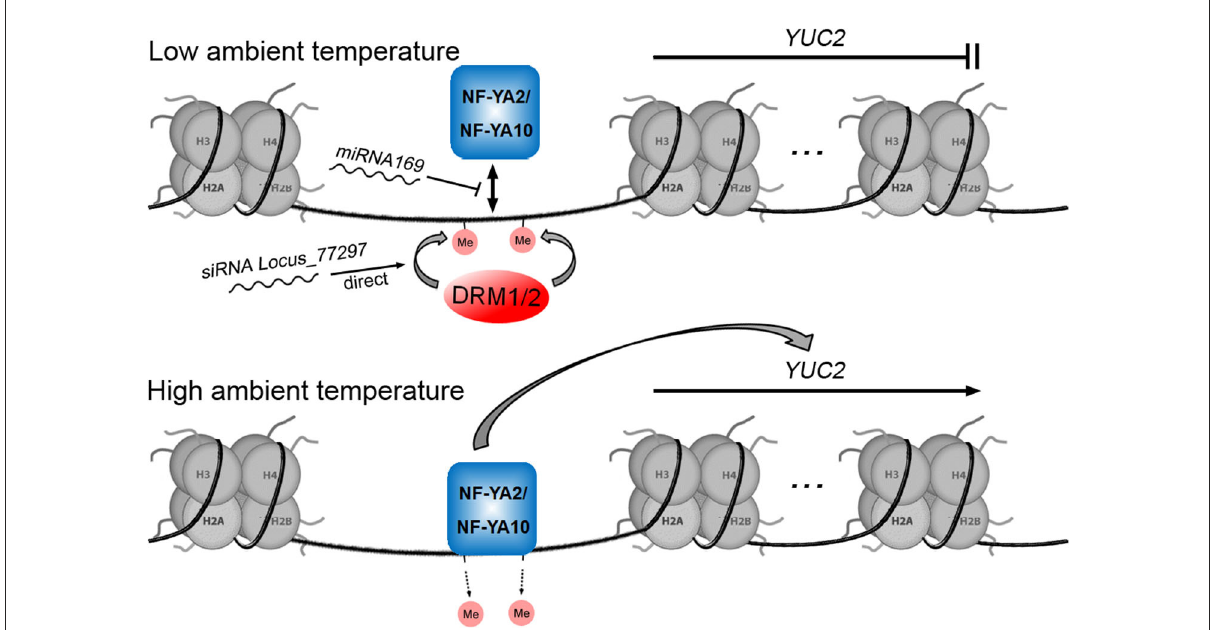
FIGURE5 Model for the involvement of DNA methylation and small RNAs in the transcriptional regulation of the auxin biosynthetic gene YUC2 .